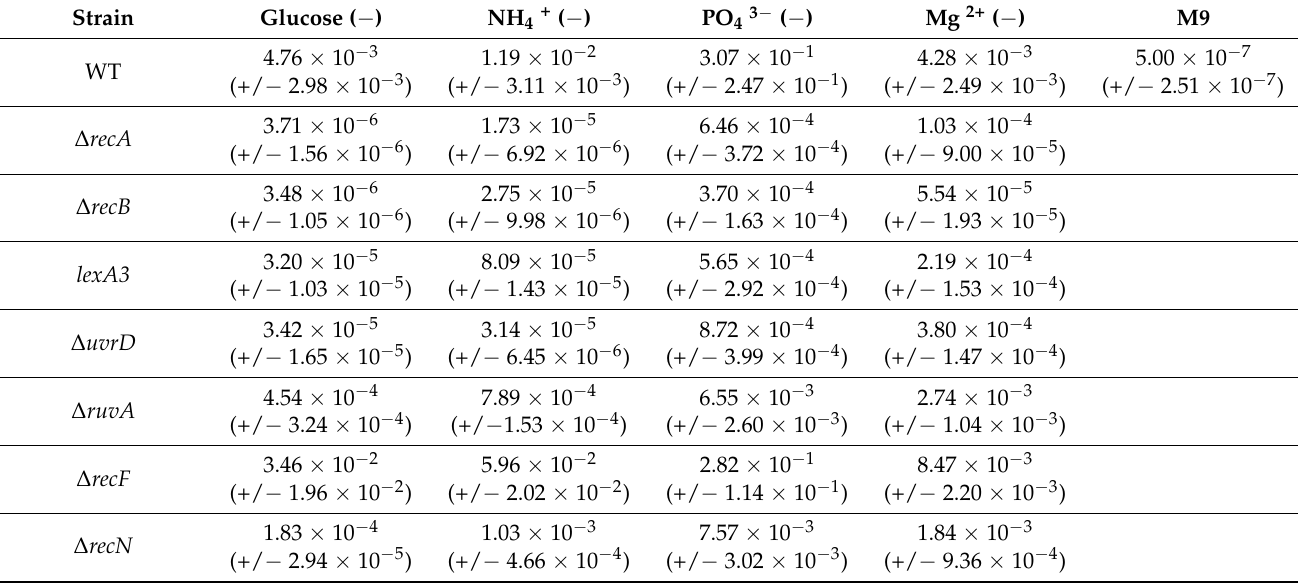
Table 2. Survival fractions after 5 h of treatment with MOXI